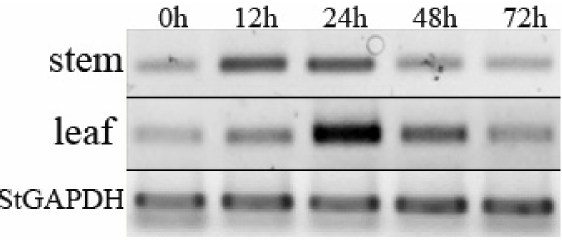
Figure 5. Expression analysis of StPP5 at different times after V. dahliae infection.